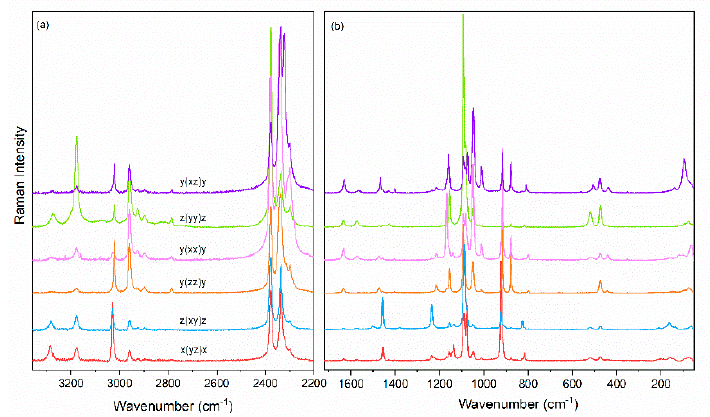
Figure 3. Polarized Raman spectra of the [MHy][Mn(H 2 POO) 3 ] single crystal in the ( a ) 2200–3360 cm − 1 and ( b ) 50–1720 cm − 1 range.